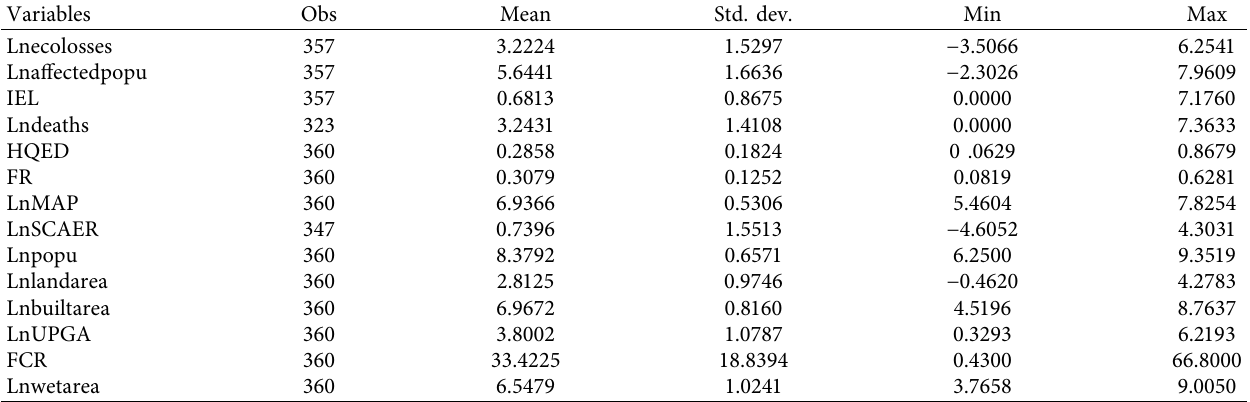
Table 3: Descriptive